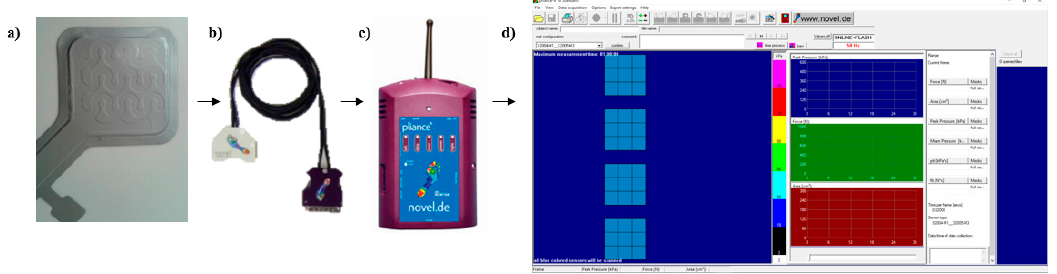
Figure 1 . Experimental set-up for data acquisition from the sensor: ( a ) One Socket Sensor XL S2004 and his wave-shaped regions connected through ( b ) a cable to ( c ) a Novel box for the signal acquisition and processing. Data have been collected and sent to a computer. ( d ) Software interface.